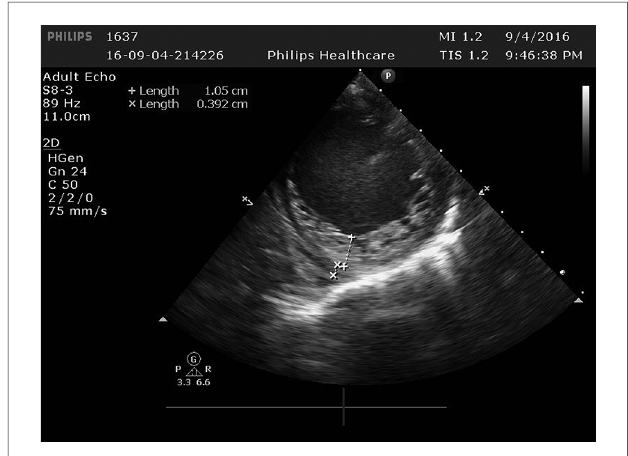
FIGURE 2 In the left ventricle, trabeculae increased signi fi cantly and protruding into the ventricle cavity, and deep recess could be seen. The thickness of the non-dense myocardium was 10.5 mm, and the thickness of the dense myocardium was 3.9 mm, and the ratio of the two was >2.